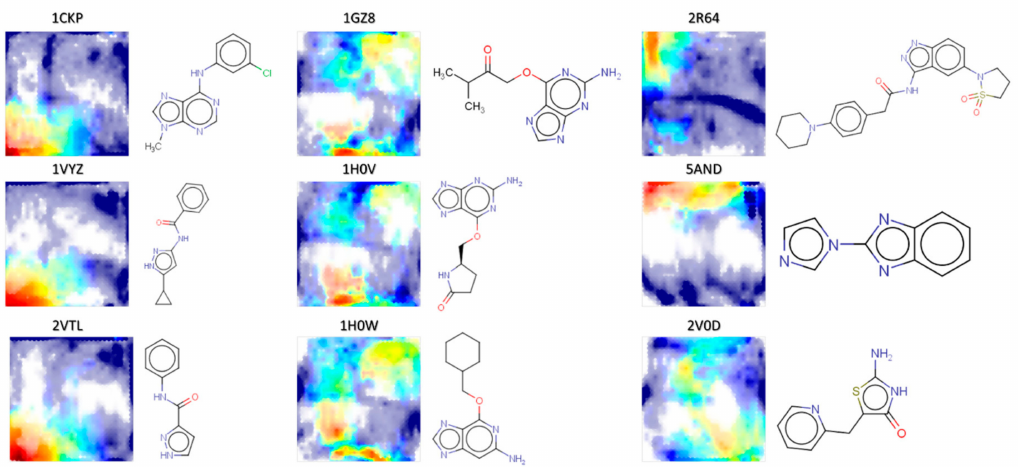
Figure 2. RMSD landscapes (red: native-like zone) of the docked conformer sets of various ligands on the CF map (including 1CKP, the ligand for which the map was